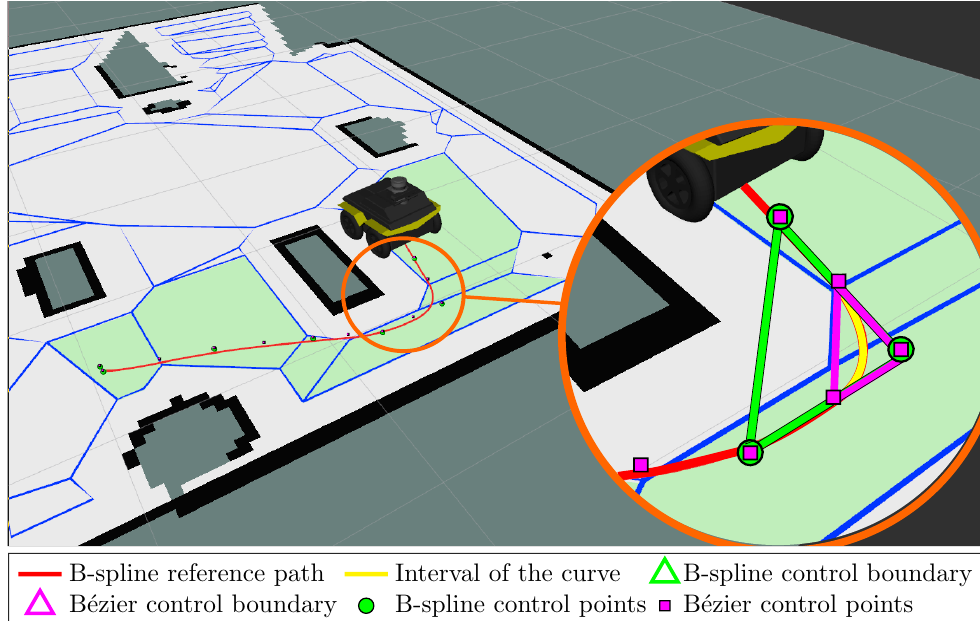
Figure 1. B-spline path planned within a polytope map with the Navigation with Polytopes (https://gitlab.rob.uni-luebeck.de/robPublic/navigation_with_polytopes, accessed on 19 February 2023)